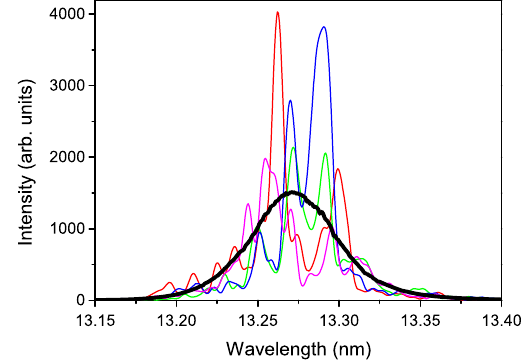
FIG. 8. Single-shot XUV spectra recorded for the 13.5 nm run (bunch 21) measured with the PG2 beam line. The spiky structure which is changing from pulse to pulse can easily be seen. The black line shows the average over hundreds of single-shot